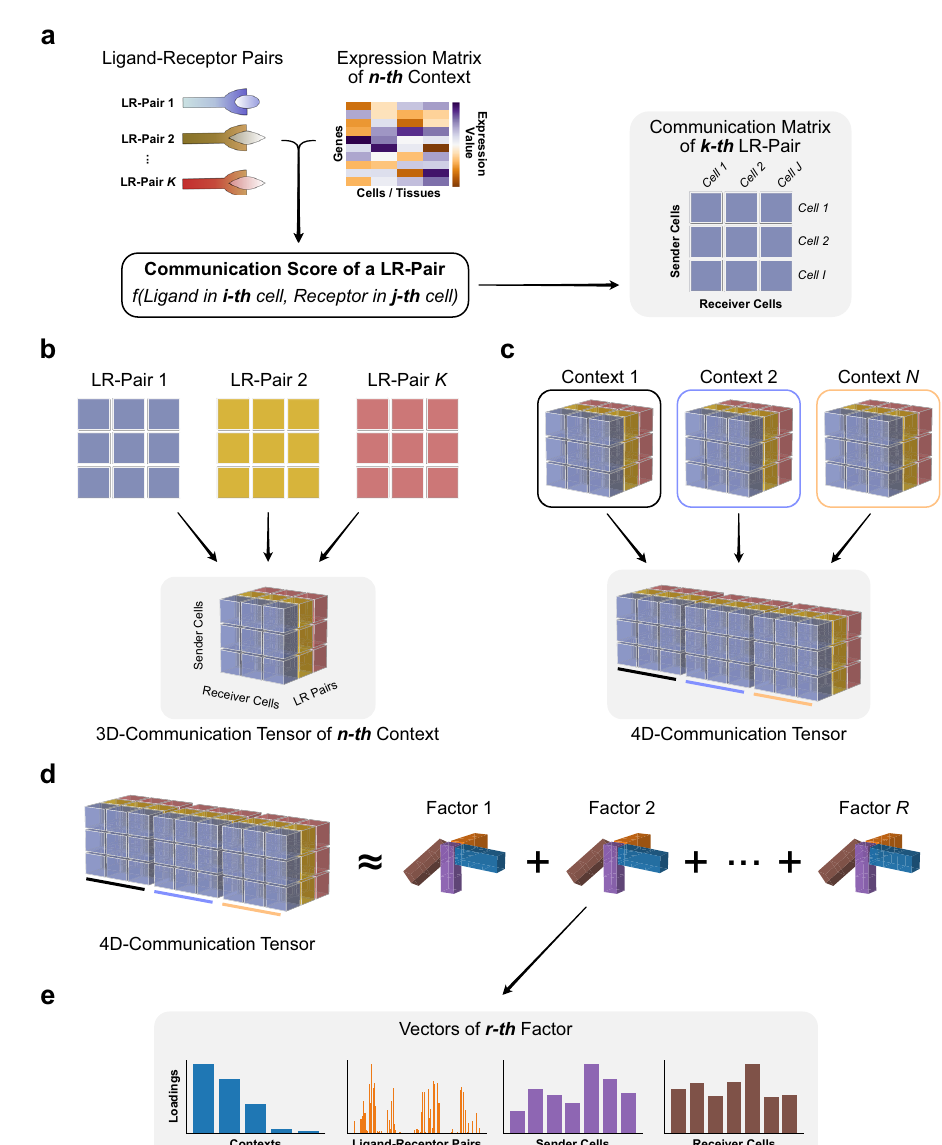
Fig. 1 Tensor representation and factorization of cell – cell communication. In a given context ( n -th context among N total contexts), cell – cell communication scores (see available scoring functions in ref. 5 ) are computed from the expression of the ligand and the receptor in a LR pair (k-th pair among K pairs) for a speci fi c sender-receiver cell pair (i-th and j-th cells among I and J cells, respectively). This results in a communication matrix containing all pairs of sender-receiver cells for that LR pair ( a ). The same process is repeated for every single LR pair in the input list of ligand-receptor interactions, resulting in a set of communication matrices that generate a 3D-communication tensor ( b ). 3D-communication tensors are built for all contexts and are used to generate a 4D-communication tensor wherein each dimension represents the contexts (colored lines), ligand-receptor pairs, sender cells and receiver cells ( c ). A non-negative TCA model approximates this tensor by a lower-rank tensor equivalent to the sum of multiple factors of rank-one (R factors in total) ( d ). Each component or factor (r-th factor) is built by the outer product of interconnected descriptors (vectors) that contain the loadings for describing the relative contribution that contexts, ligand-receptor pairs, sender cells and receiver cells have in the factor ( e ). For interpretability, the behavior that context loadings follow represent a communication pattern across contexts. Hence, the communication captured by a factor is more relevant or more likely to be occurring in contexts with higher loadings. Similarly, ligand-receptor pairs with higher loadings are the main mediators of that communication pattern. By constructing the tensor to account for directional interactions (panels a, b), ligands and receptors in LR pairs with high loadings are mainly produced by sender and receiver cells with high loadings,